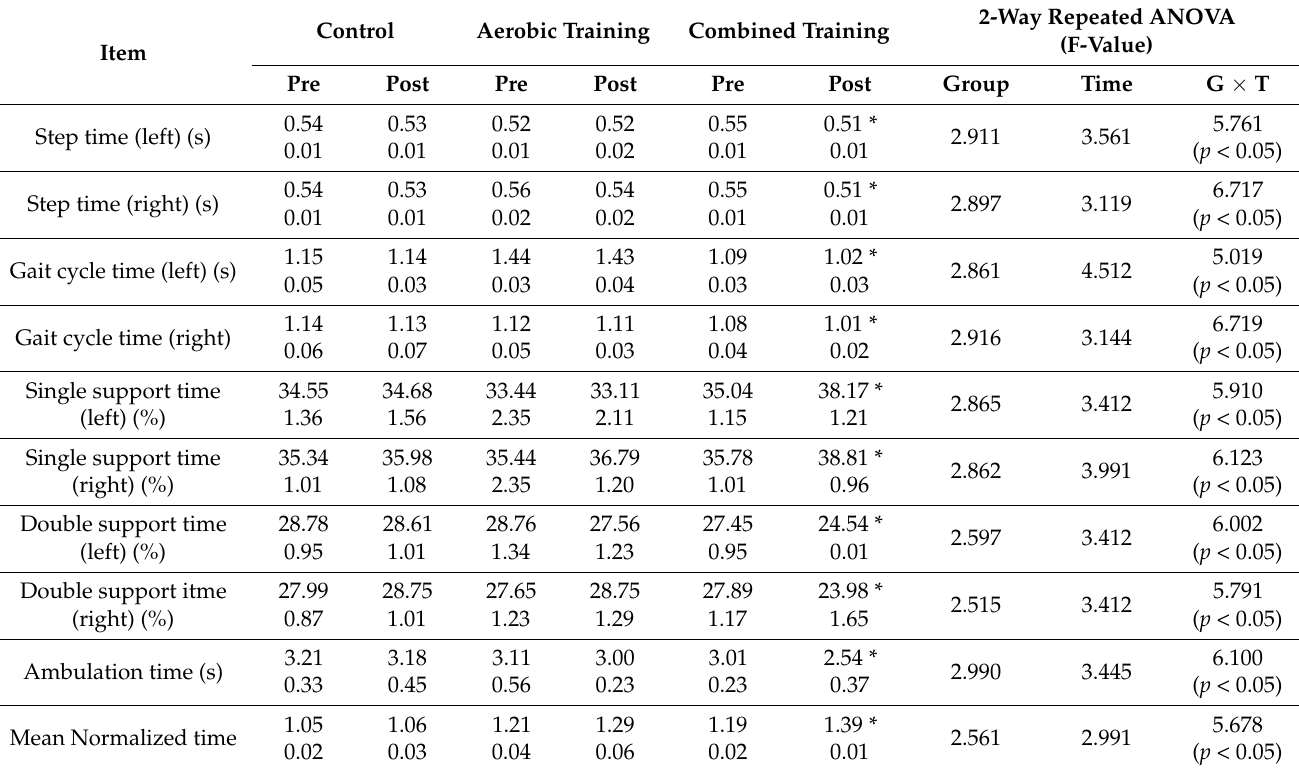
Table 3. Changes of temporal parameters of gait after 12 week exercise training.